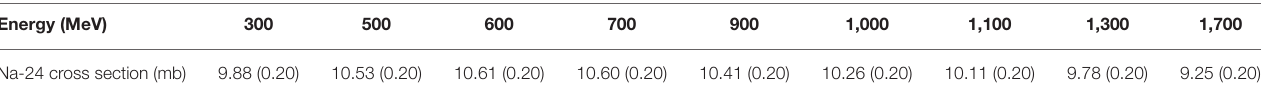
TABLE 1 | Production cross-section values of the Al-27(p,x)Na-24 reaction used as monitor. Energy (MeV) 300 Na-24 cross section